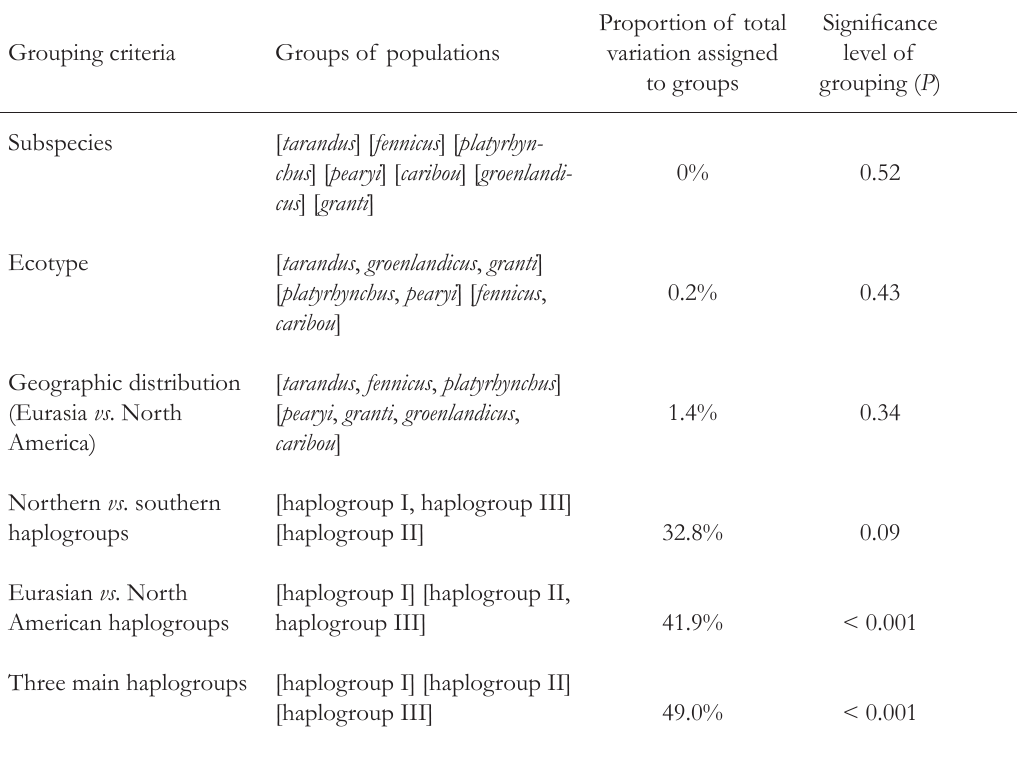
Table 4. Analysis of molecular variance of mtDNA haplotypes of reindeer and caribou based on several possible groupings of the populations